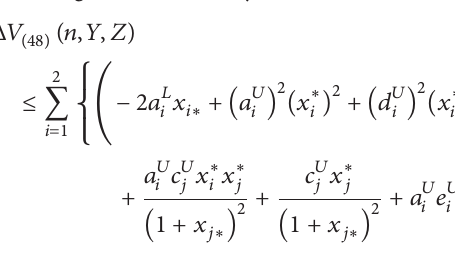
Figure 3: Uniformly asymptotic stability. (a)–(d) Time-series of 𝑥 ∗ 1 (𝑛), 𝑥 ∗ 2 (𝑛), 𝑢 ∗ 1 (𝑛) and 𝑢 ∗ 2 (𝑛) with initial values 𝑥 ∗ 1 (0) = 1.18, 𝑥 ∗ 2 (0) = (0) = 0.024, and 𝑢 ∗ 0.96, 𝑢 ∗ 1 (0) = 0.012 for 𝑛 ∈ [0, 100] , 0.034, and 𝑢 2